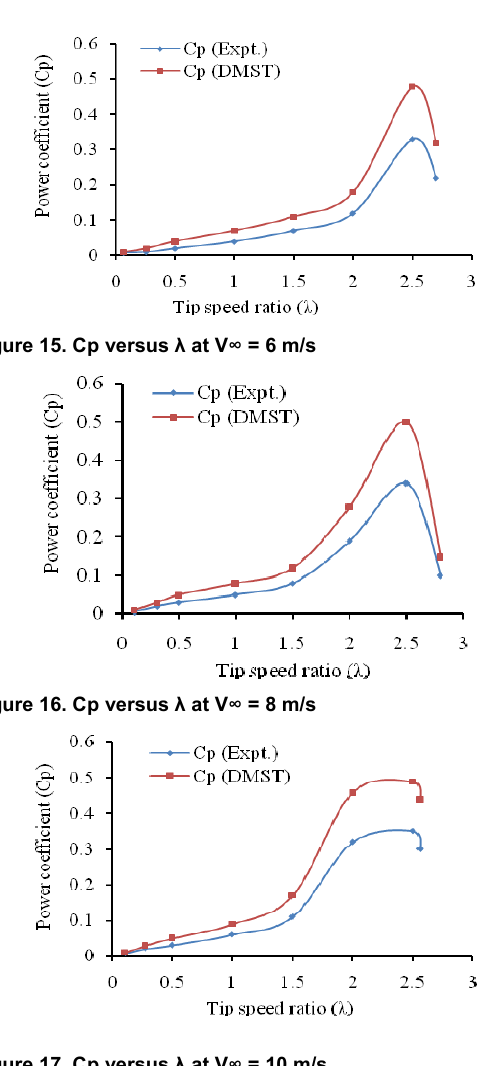
Figure 17. Cp versus λ at V ∞ = 10